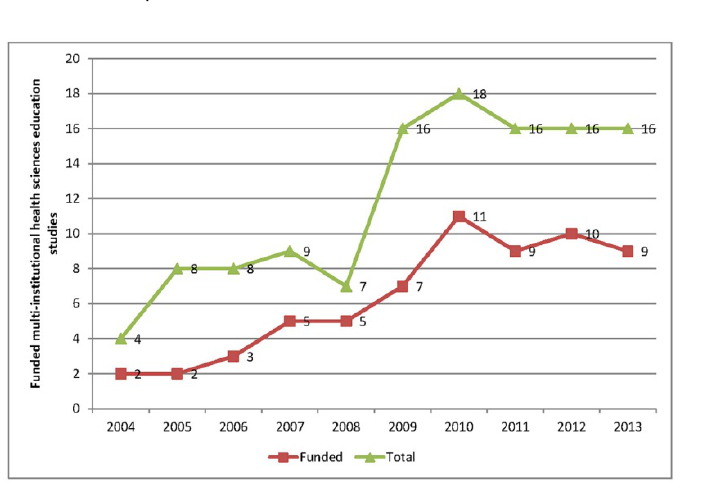
Figure 3 Funding trends of the reviewed